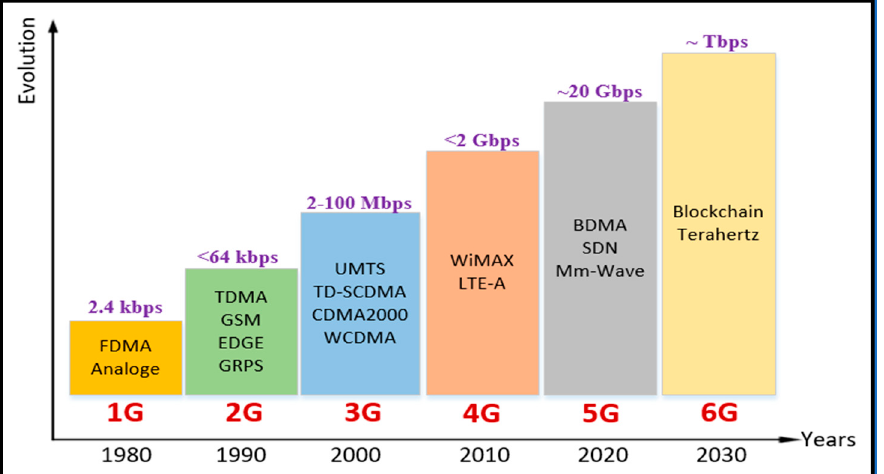
Figure 3. Data rate by technology: 1G to 6G [53].